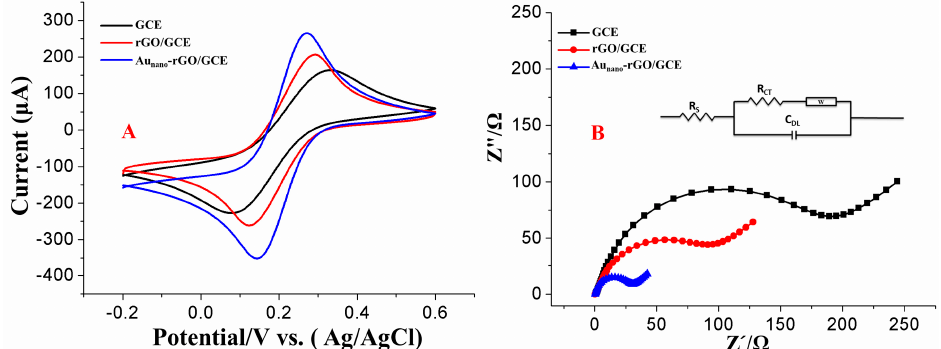
Figure 4. CV ( A ) and EIS ( B ) results for bare GCE, rGO/GCE and rGO-Au nano /GCE in a solution of 5 mM [Fe(CN) 6 ] 3 − /4 − containing 0.1 M KCl.